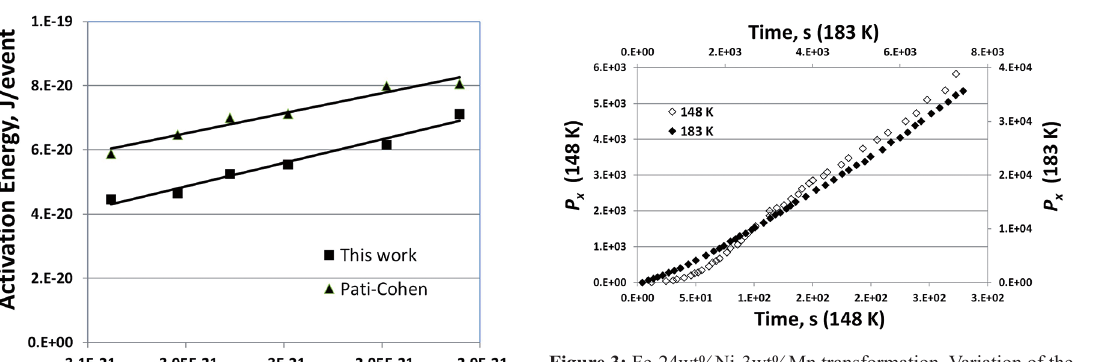
Figure 3: Fe-24wt%Ni-3wt%Mn transformation. Variation of the autocatalytic factor related to the martensite fraction transformed, P , with time at two temperatures for X